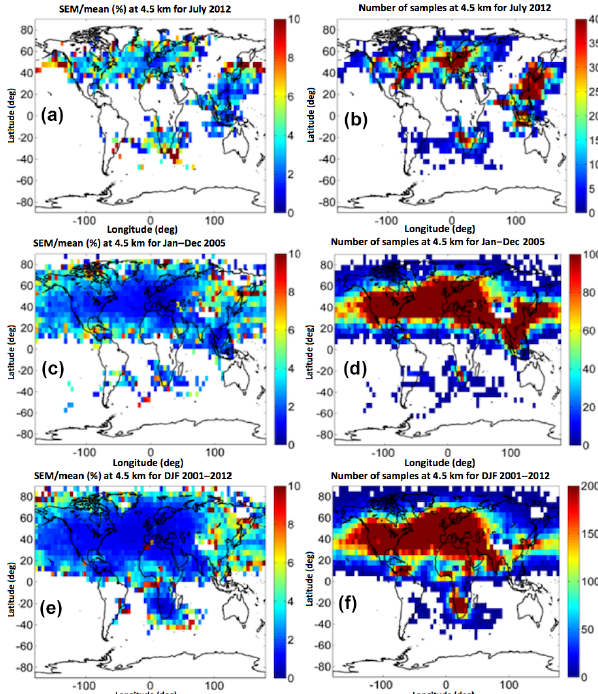
Figure 2. The standard error of the mean (left panels) and number of samples (right panels) for monthly (July 2012), annual (2005), and seasonal (DJF 2001–2012) means at 4.5km altitude above sea level. The month and year shown are chosen as typical; other months and years show similar patterns. The data are binned on a 5 ◦ × 5 ◦ lati- tude and longitude